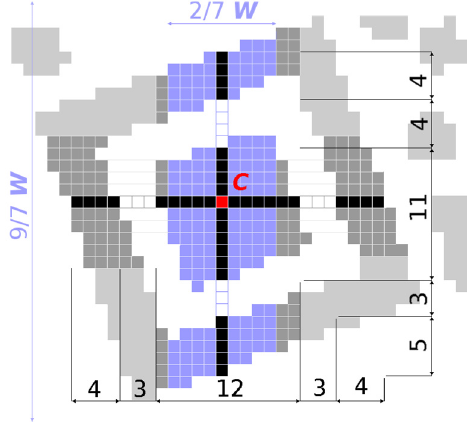
Figure 5. Finder pattern candidate matching 1:1:3:1:1 in both axes.